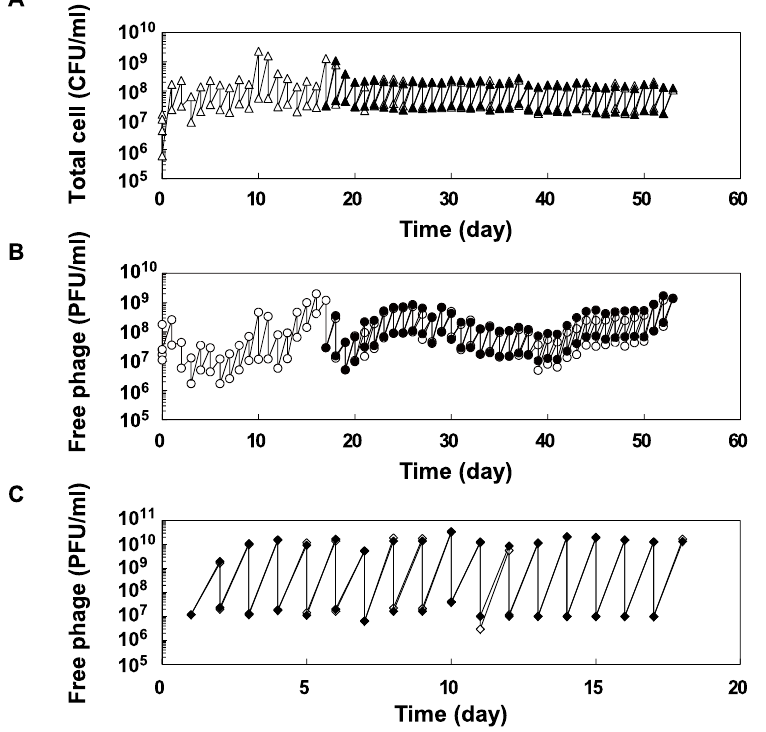
Figure 2. Population dynamics in the copropagation or Q b propagation experiments. (A) Population dynamics of E. coli density (CFU/ml) in the copropagation experiments. Mixed cultures were divided into 2 lines on the 18 th day, equivalent to 59 replication generations, and propagated independently for a further 36 days (line 1 and line 2). On the 10 th and 17 th days, we restarted the copropagation experiment from stock cultures stored at 2 80 u C. The open and closed triangles indicate the cell density of line 1 and line 2, respectively. (B) Population dynamics of free Q b density (PFU/ml) in copropagation experiments. Open and filled circles indicate the free phage density of line 1 and line 2, respectively. (C) Population dynamics of free Q b density (PFU/ml) in the Q b propagation experiment. The open and filled diamonds indicate the free phage density of line 3 and line 4, respectively. doi:10.1371/journal.pgen.1002188.g002 (Table 2). The evolved phage M54(P) and M163(P) showed higher fitness on the evolved host M54(C) with partial resistance than